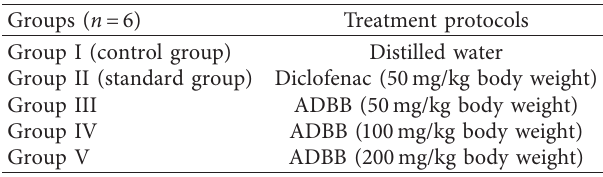
Table 1: Treatment protocols in different groups of rats for anti- inflammatory and analgesic